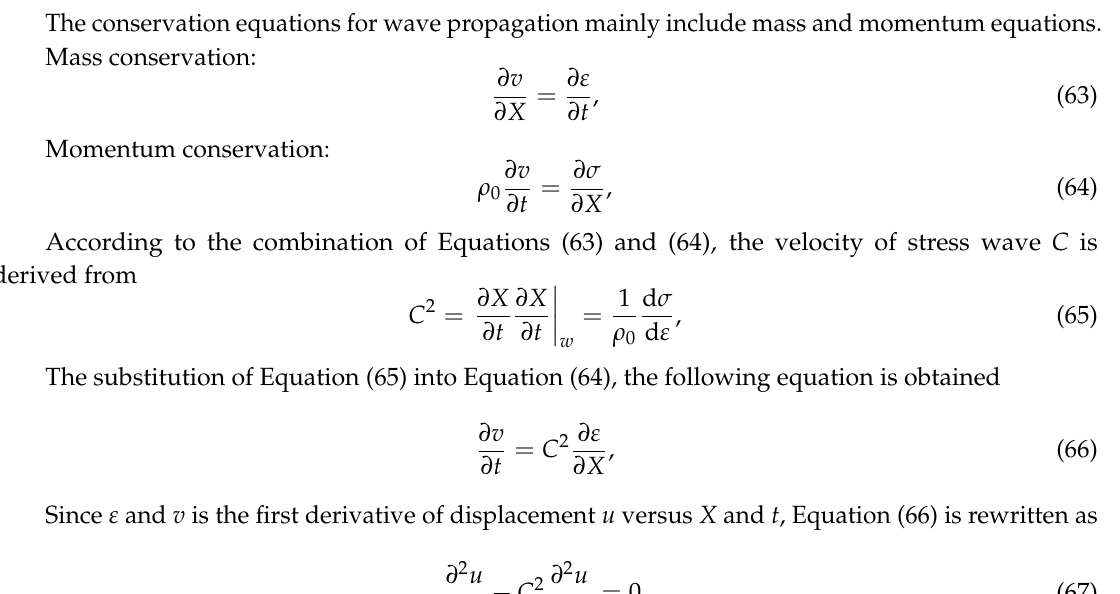
Figure 7. Schematic of background nodes and material points in a one-dimensional model.